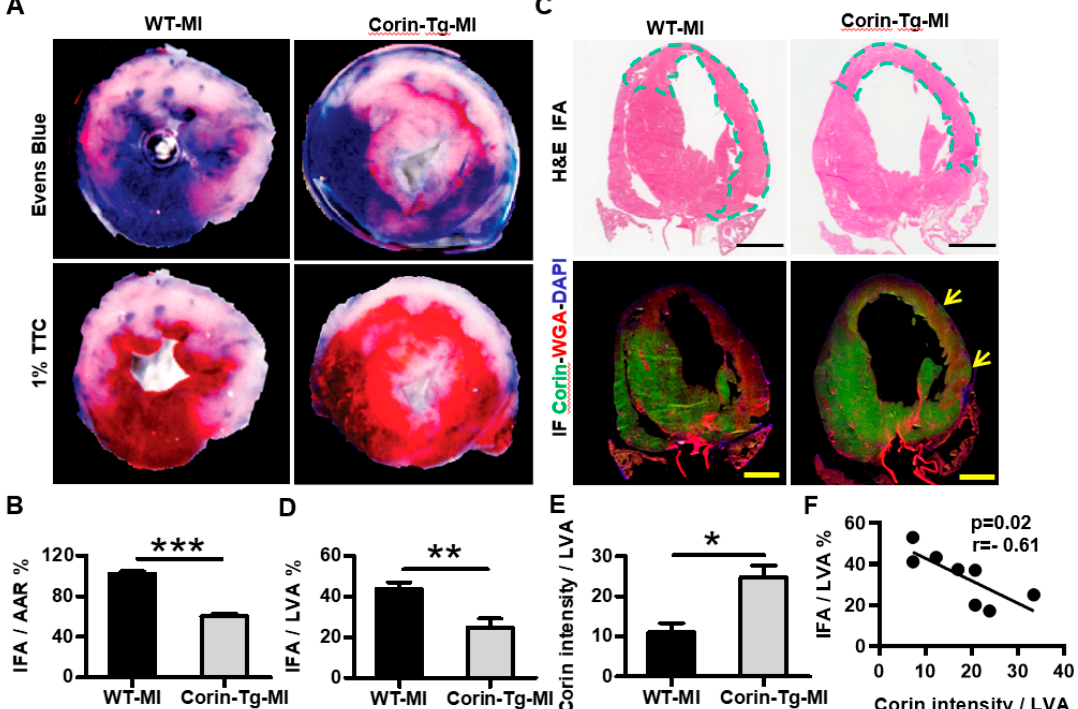
Figure 1. Cardiac-specific overexpression of corin decreases infarct size 24 h post-MI. ( A ) Area at risk for ischemia (AAR; Evans blue staining) and infarct area [IFA; 1% 2,3,5-triphenyl-2H-tetrazolium chloride (TTC)] in representative heart sections from wild-type (WT) & corin-Tg mice 24 h post-MI. ( B ) AAR and IFA were measured in heart sections using Image-Pro Plus software and are shown as the ratio of IFA to AAR. Data represent means ± SE of n = 7 mice per group. ( C ) Comparison of the IFA and the area of low corin expression in coronal heart sections. Representative images with H&E staining (top panel) and corin (green) & WGA (red) double-immunofluorescence (IF) staining (DAPI, blue, bottom panel), bar = 100 µ m. The IFA was di ff erentiated from non-infarct area by the characteristic eosinophilic staining (highlighted with a dotted line) on H&E sections. In contrast to the WT post-MI heart, there was residual myocardial corin expression (indicated by yellow arrows) in the ischemic area of corin-Tg hearts post-MI (IF sections). ( D ) The IFA (eosinophilic area) and total left ventricular area (LVA) of myocardium were measured using Image-Pro Plus software in H&E stained sections of each heart and the ratio of IFA to LVA was calculated as shown in the bar graph ( n = 4 per group). ( E ) Corin intensity and LVA were measured using Image-Pro Plus software. The ratios of corin intensity to LVA are shown in the bar graph ( n = 4 per group). ( F ) Linear regression analysis of IFA / LVA % and corin intensity / LVA in all WT-MI and corin-Tg post-MI groups. Data represent means ± SE for each group. * p < 0.05, ** p < 0.01, *** p < 0.001.